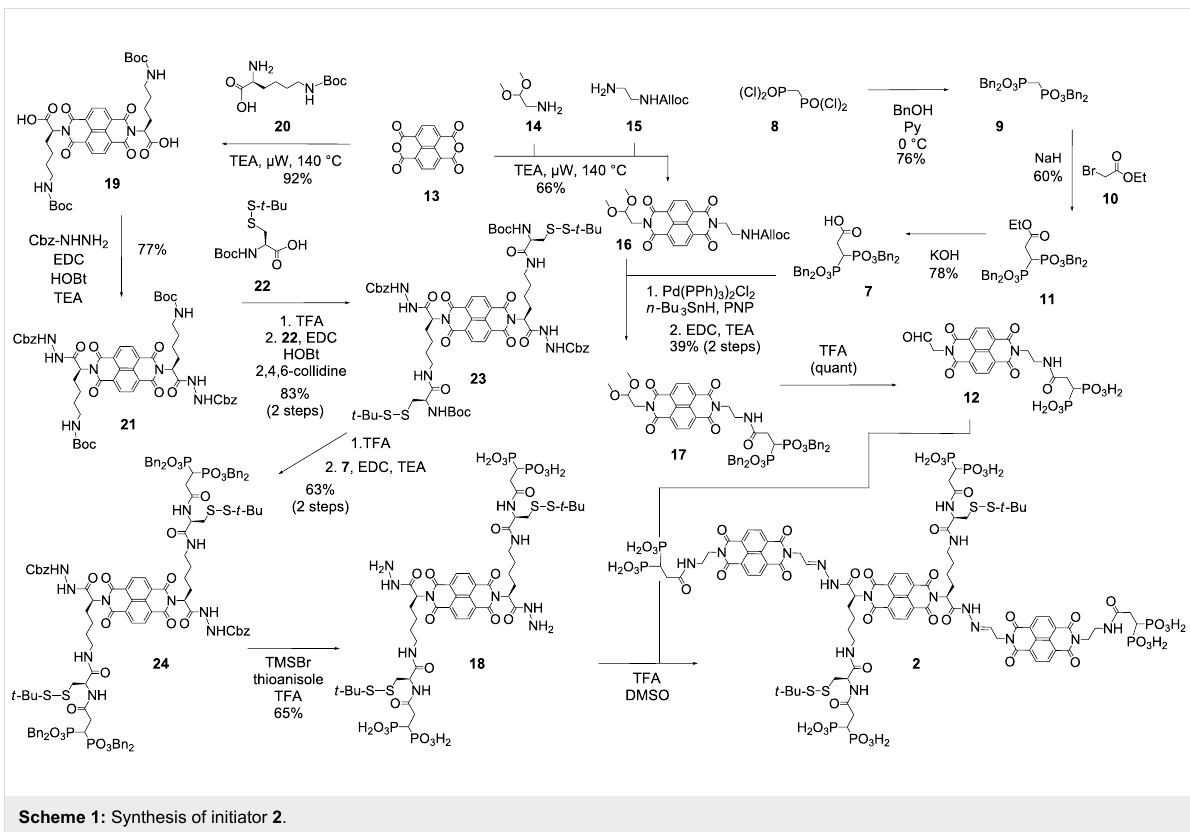
molecular n/p-heterojunctions with oriented multicomponent/ color antiparallel redox gradients [2,3]. With n/p contact areas maximized down to the molecular level, photoinduced charge separation (i.e., charge generation) should be as favorable as directional charge translocation (i.e., charge separation) along redox gradients in the molecular channels. With photosystem 1 , these high expectations could finally be tested